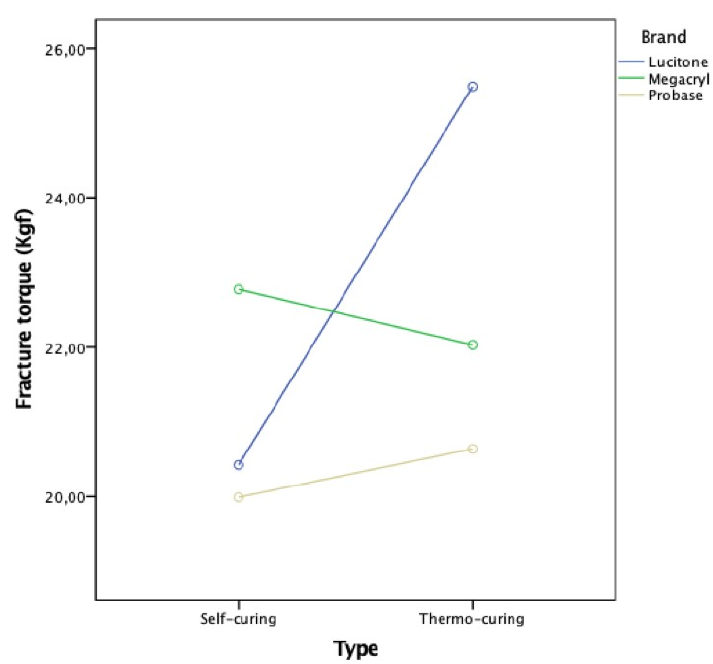
Figure 10. Fracture torque evaluation: brand/resin Figure 10 . Fracture torque evaluation: brand/resin type